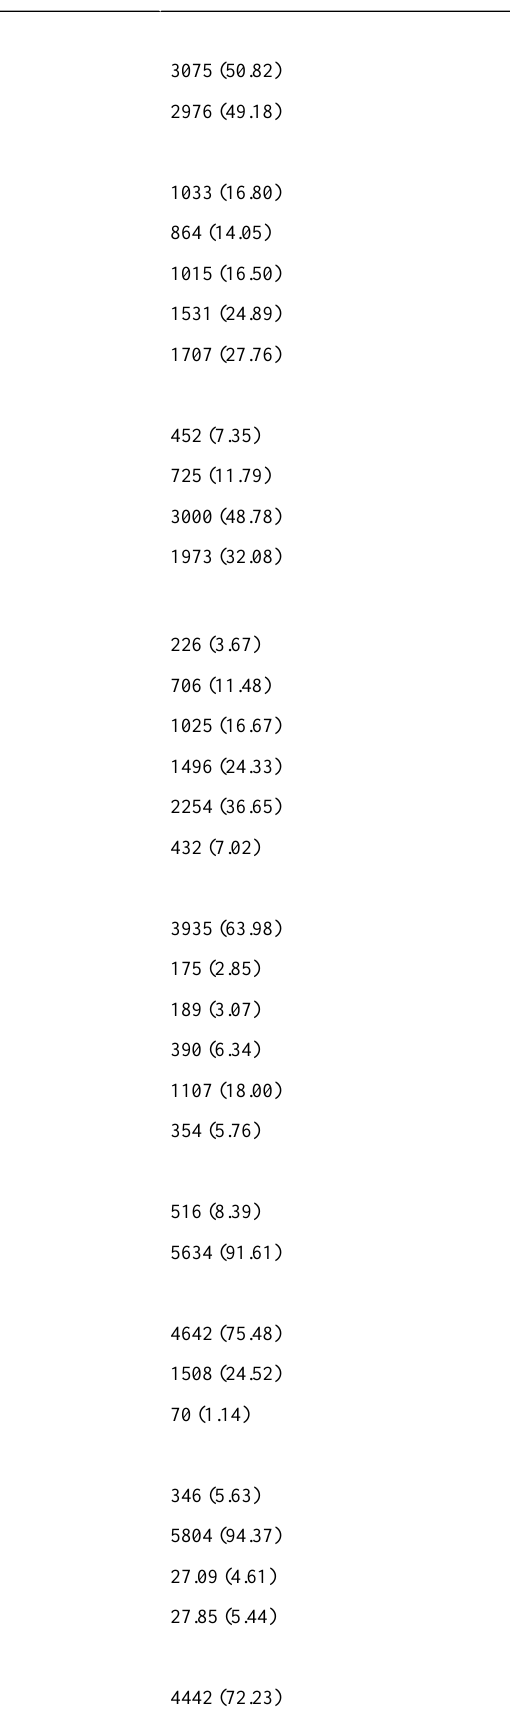
Value, n (%) or mean